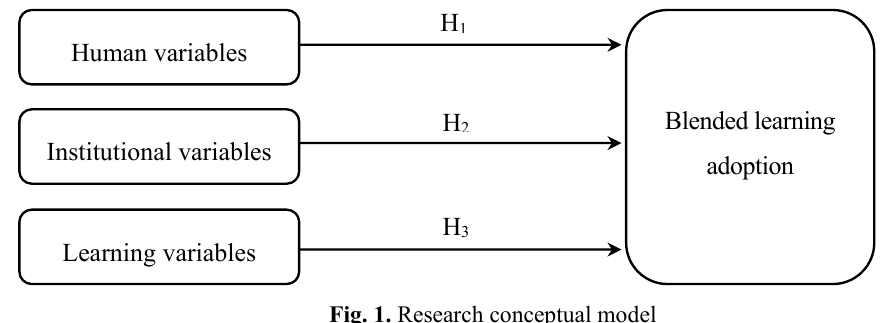
Fig. 1. Research conceptual